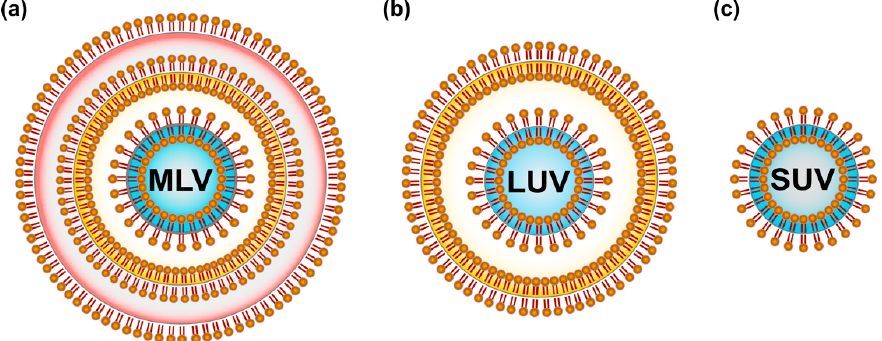
Figure 4. Classification of liposomes based on the lamellarity: ( a ) Multilamellar vesicles (MLV) are composed of many lipid bilayers and range from 1–5 µm in size; ( b ) Large unilamellar vesicles (LUV) are in the size range of 100–250 nm with a single lipid bilayer; ( c ) Small unilamellar vesicles (SUV) consist of a single phospholipid bilayer surrounding an aqueous phase with a size range of 20–100 nm. Liposomes are the most established drug-delivery vehicle, with many clinical products to date.